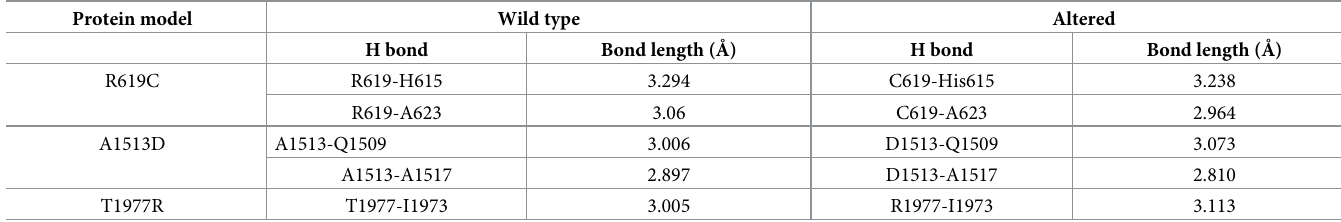
Table 6. Alteration of H bond interactions and their lengths due to amino acid substitutions. Protein